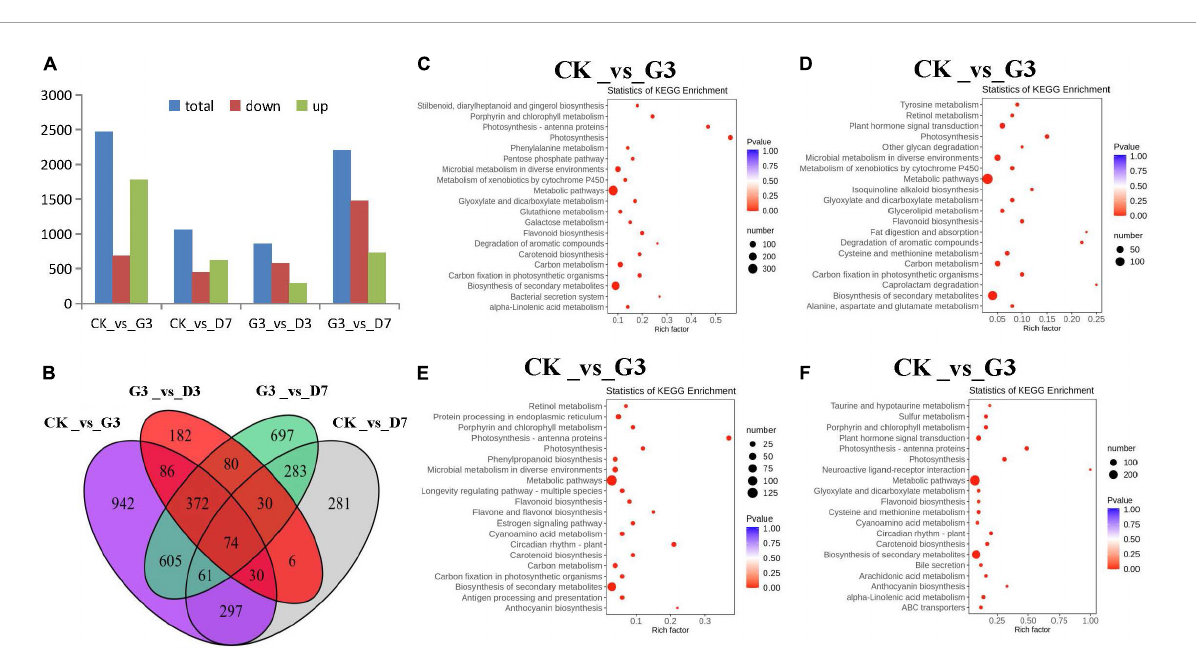
no less than 30 was greater than 62%, indicating that a high proportion of reads from each sample were compared against the reference genome ( Supplementary Table 7 ). Correlation thermography showed that the square of the Pearson correlation coefficient (r 2 ) of the three biological replicates in the group